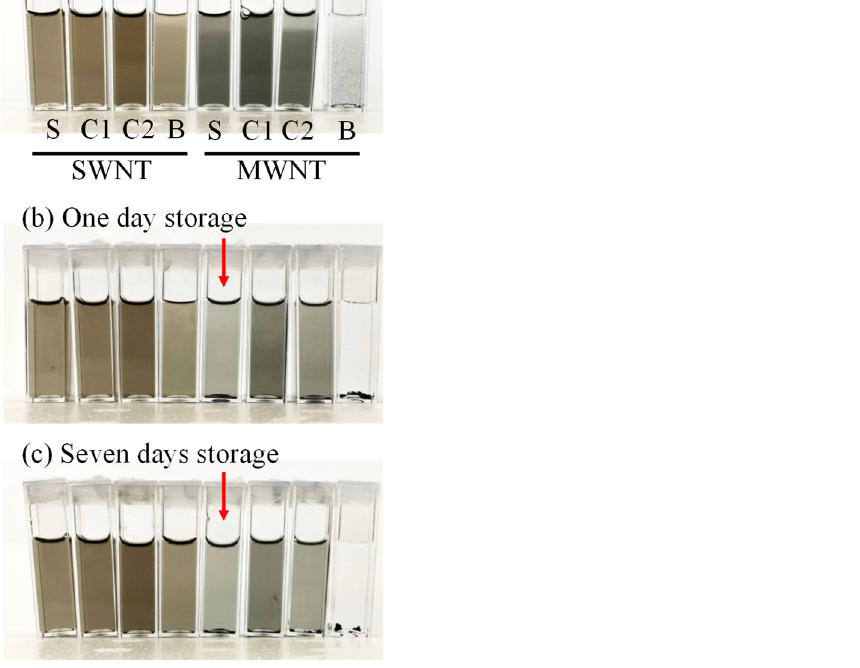
Figure 1. Photographs of SWNT and MWNT suspensions in the optical cuvettes. The prepared suspensions were diluted 30 times (final concentration: 0.017 mg/mL CNTs, 0.017% detergents), and 500 μ L of the diluted suspensions were sealed in an optical cuvette. ( a ) As-prepared ( b ) 1-day storage ( c ) 7-day storage S: SDS, C1: Coconut1, C2: Coconut2, B: Bamboo.